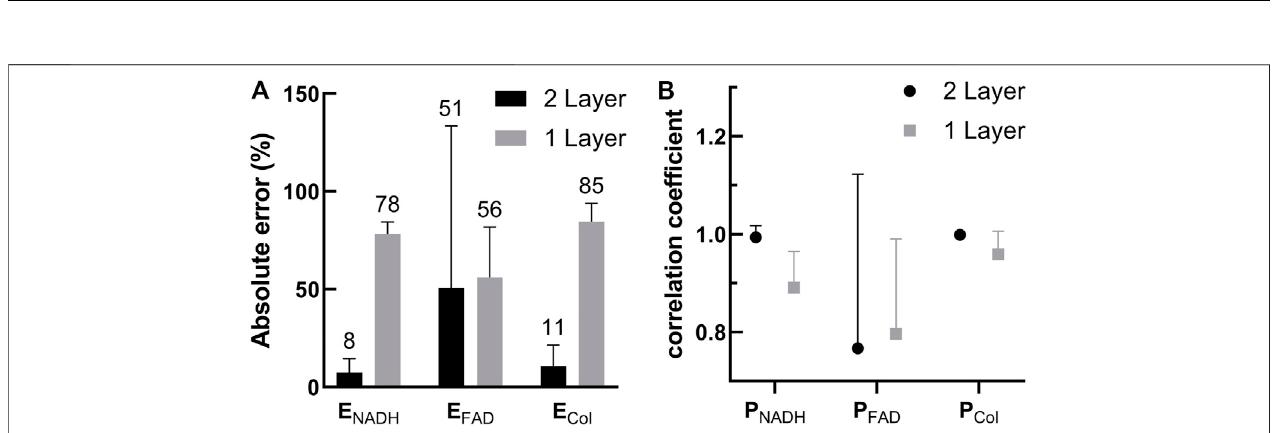
FIGURE 5 | (A) Comparison between errors of μ s ′ ( λ ) estimated by the two-layer and one-layer forward models. The errors were calculated as root-mean-square percentagesacrosstheanalyzedwavelengthrange (B) Absolutepercenterrorsofextracted Th and C Hb andabsoluteerrorsofextractedStO 2 obtainedbythetwo-layer forward model. Errors of the latter two parameters estimated by the one-layer forward model are also shown for comparison.